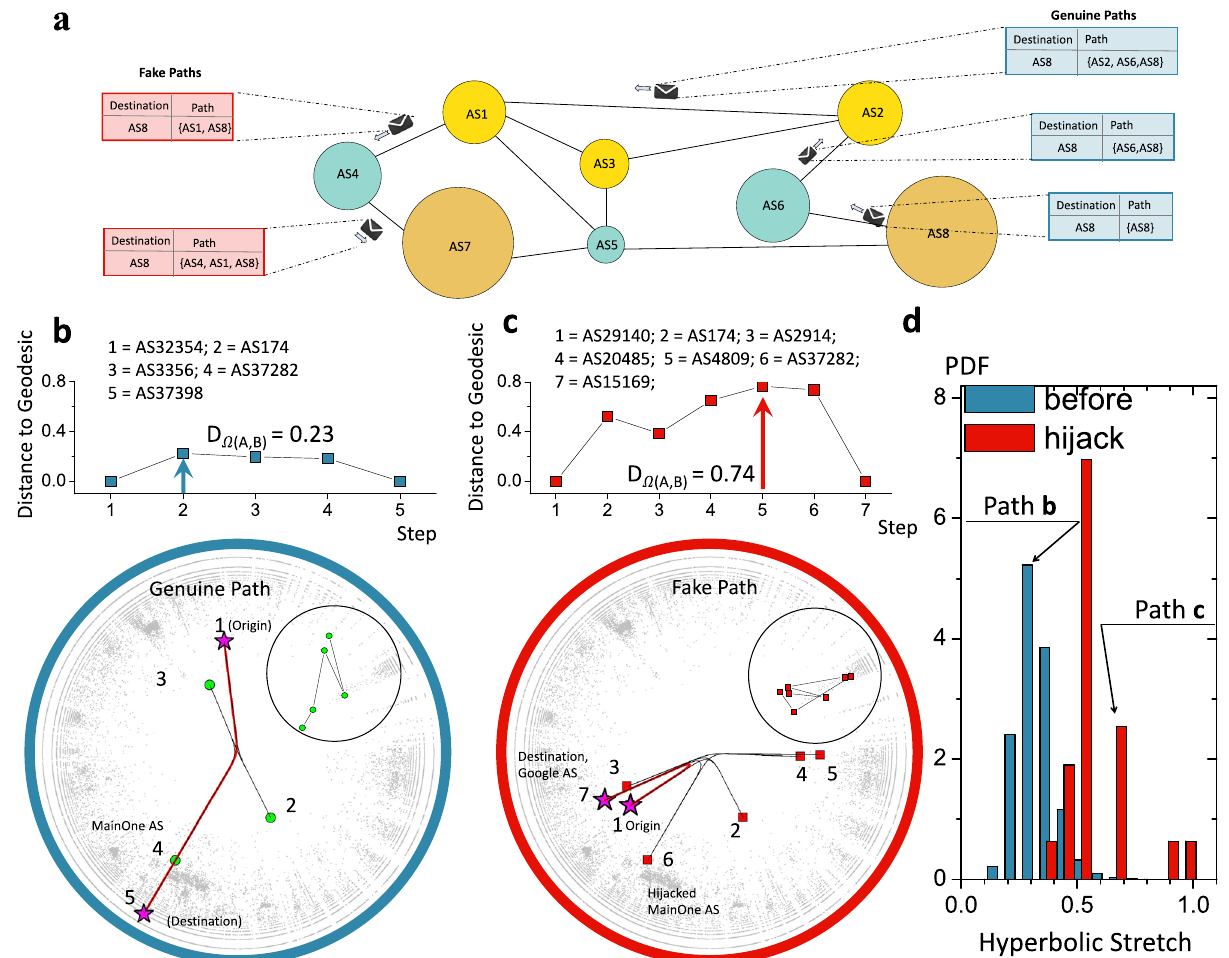
Fig. 4 | Anomaly detection in interdomain Internet routing. a Interdomain routingataglance.ShownistoynetworkoftheInternetattheAutonomousSystem (AS) level, where nodes are autonomous systems and links are data transfer agreements.Shownontheright-handsideisthedistributedcalculationsofpathsto AS8. The generation of paths on the left-hand side is an example of routing instability. AS1 falsely claims the direct connection to AS8. This information is propagatedbytheborder-gateway-protocol(BGP) fi rsttoAS4andthentoAS7.Asa result,AS4andAS7havefakepathinformationtoAS8.Routingpathsfollowingthe hijack of the Google AS pre fi xes by the MainOne AS, see Section SV. b An example of a routing path traversing NigerianInternet Service ProviderMainOne (AS37282) announced before the pre fi x hijack. Green circles are ASes constituting the path; the solid red line is the hyperbolicgeodesicconnecting the origin-destination pair. Distance to geodesic for every node constituting the routing path is shown above the hyperbolic map. The hyperbolic stretch of the BGP path, Eq. (1), is the largest